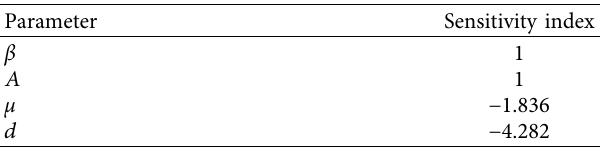
Table 1: The sensitivity index of R with respect to different 0 parameters. Parameter Sensitivity index β 1 A 1 μ − 1.836 d −